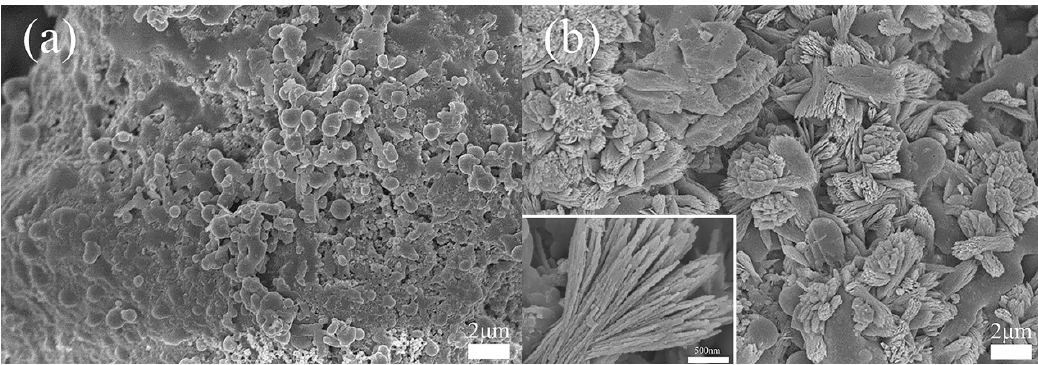
/ ABS / TPU ( b ) Ca-MOF / ABS / 3